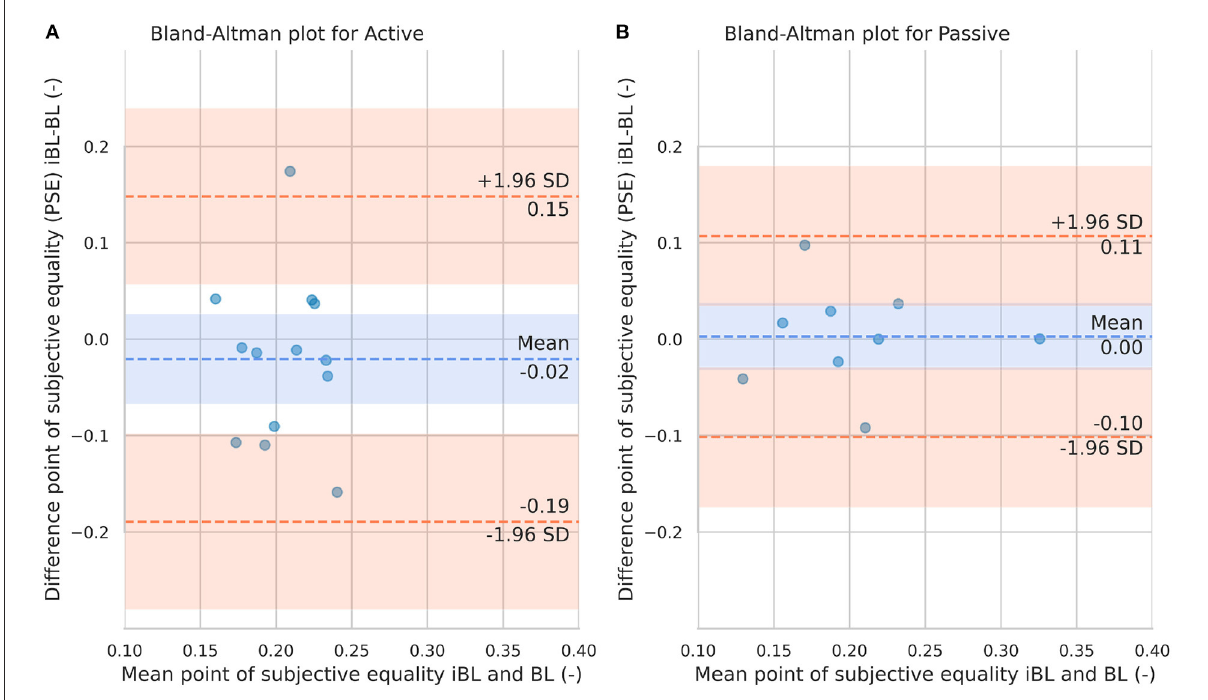
FIGURE8 Bland-Altman plots for the point of subjective equality in iBL and BL for the Active condition (A) and passive condition (B) . The blue dashed line represents the mean difference between iBL and BL. The lower and upper orange dashed lines represent the lower and upper 95% confidence limits,